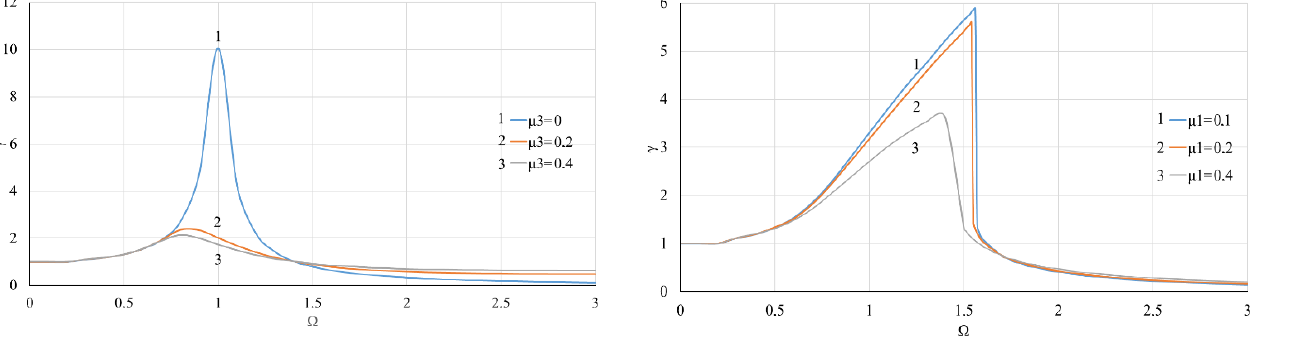
Figure 9. Dependence of the moment of force transmissibility of the system γ on the rotor velocity (cid:127) with nonlinear stiffness of the support K 3 = 0 . 1 and at different values of the coefficient of linear viscous damping µ 1 .